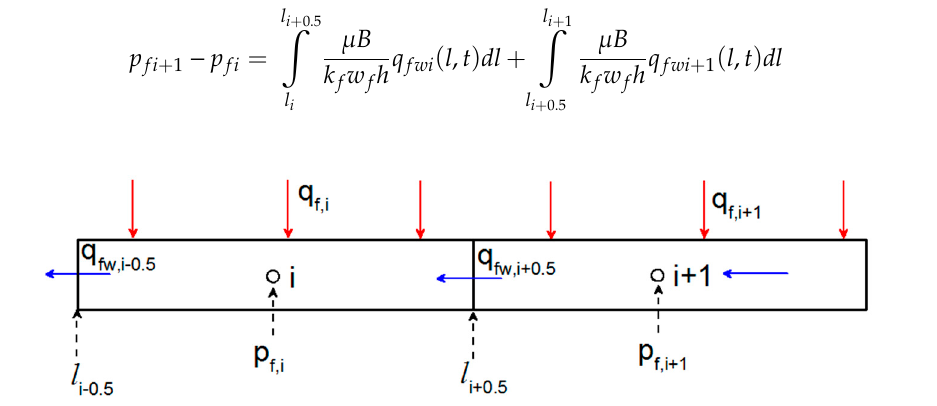
Figure 4. Schematic of fracture discretization.